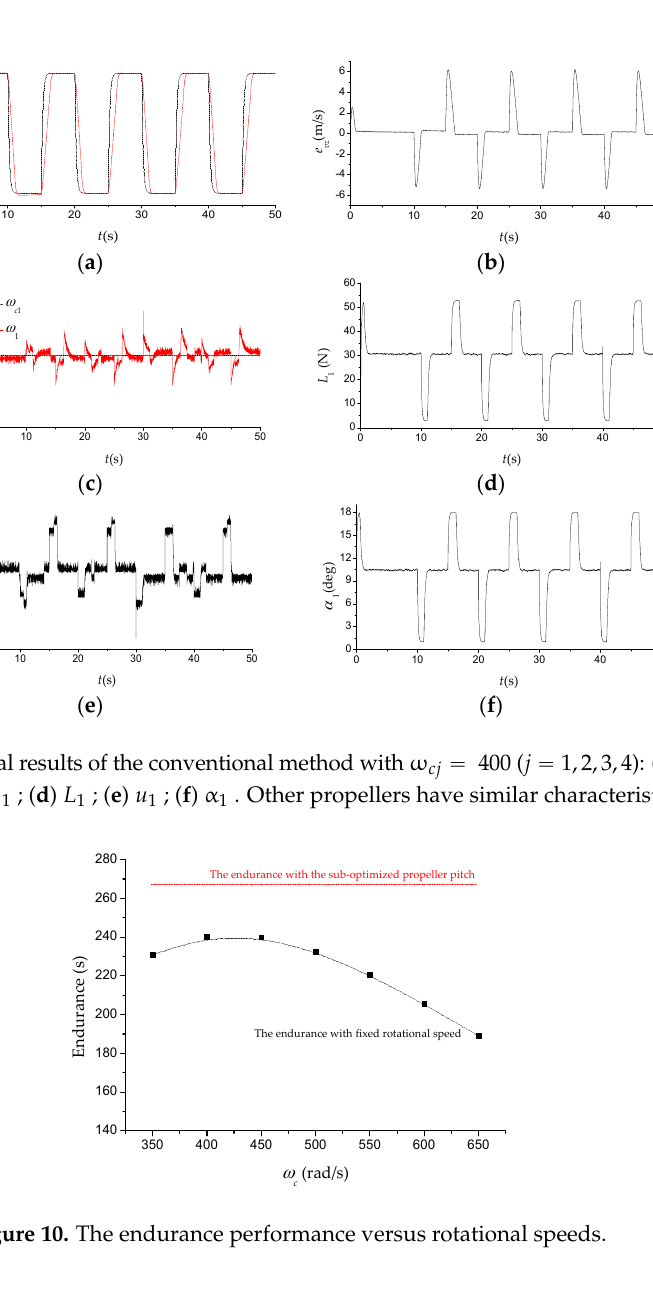
Figure 10. The endurance performance versus rotational speeds.